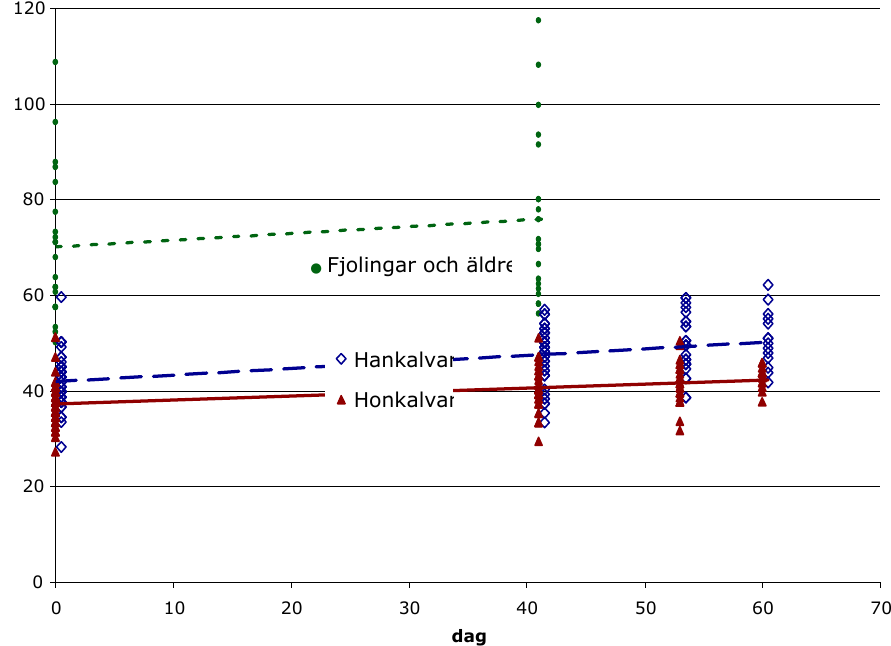
Fig. 1 . Förändring av levande vikt under försöket i olika kategorier av renar (vikten är korrigerad med hänsyn till slaktutbyte vid de olika tidpunkterna för att kompensera för eventuella olikheter i magfyllnad).